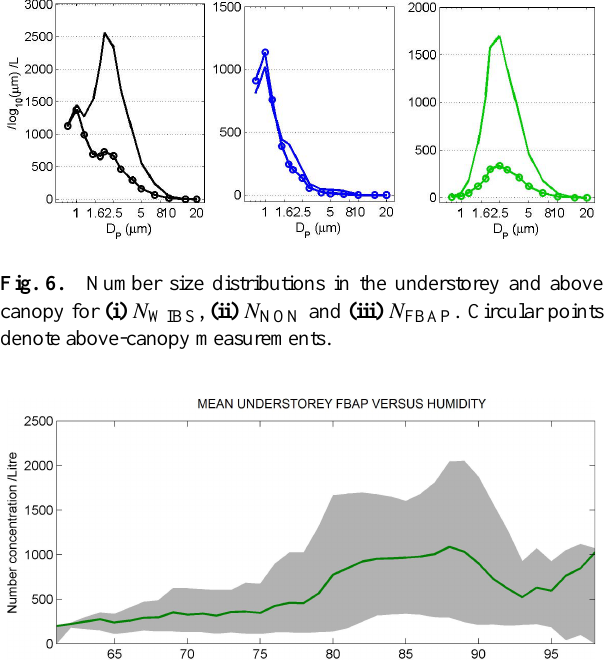
N FBAP at 2–3 µm.